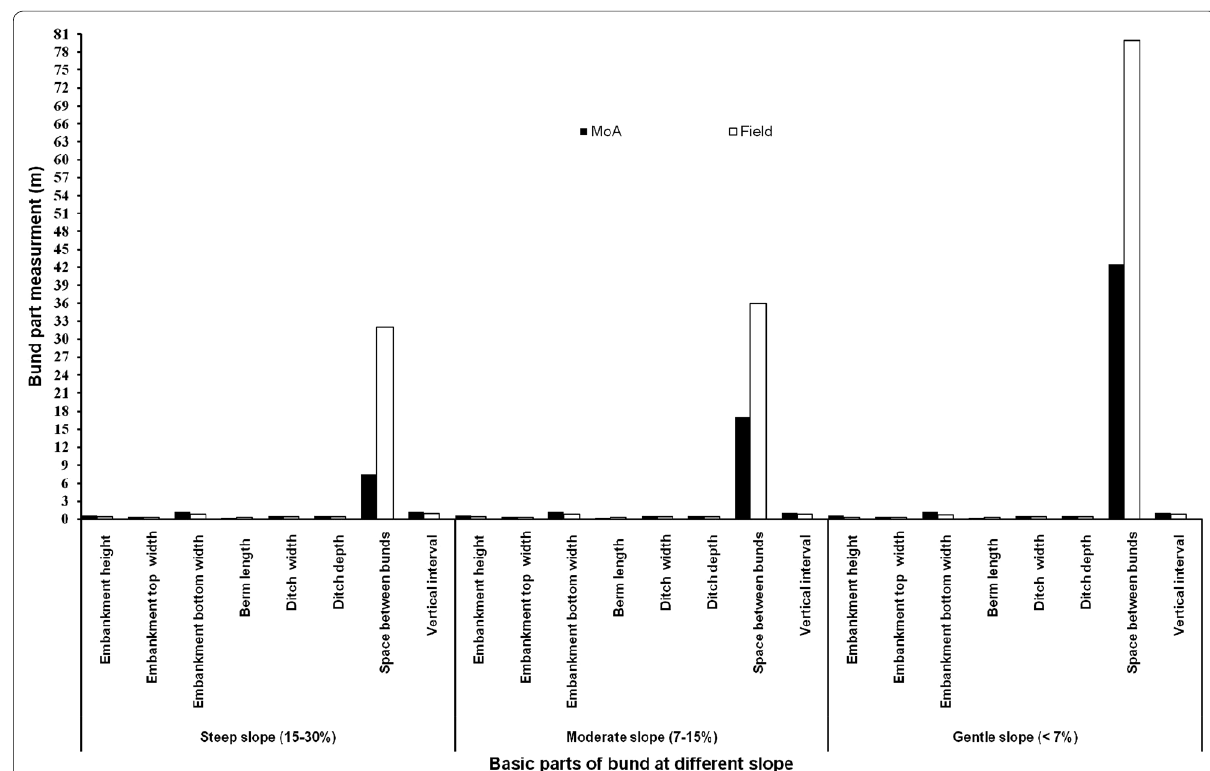
Fig. 2 Comparison of graded soil bunds constructed in Lemo district against standards established by the Ministry of Agriculture and Rural Development